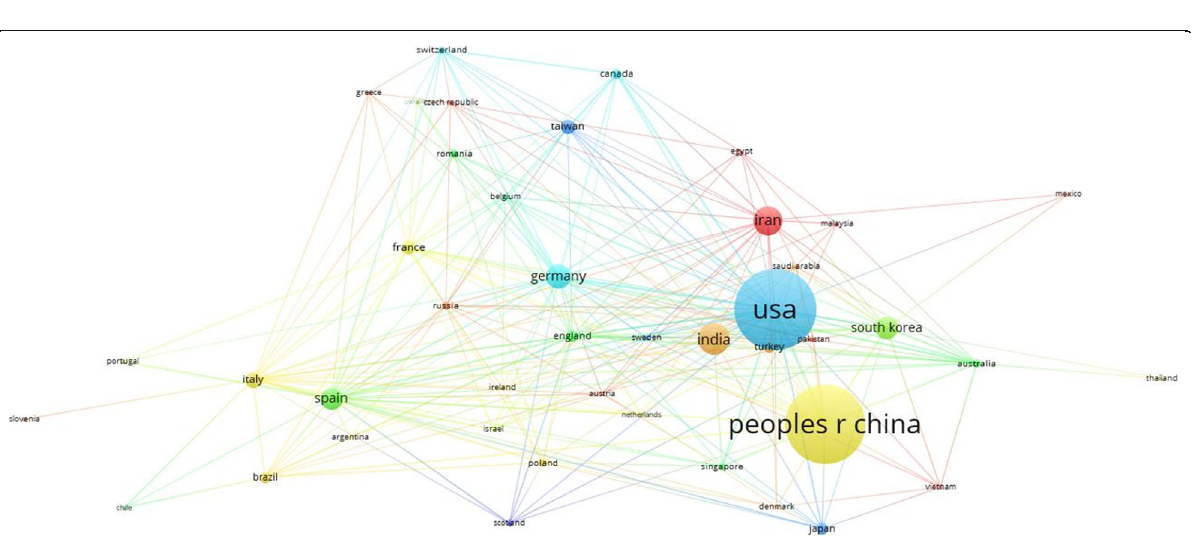
Fig. 6 Countries sorted by the number of articles